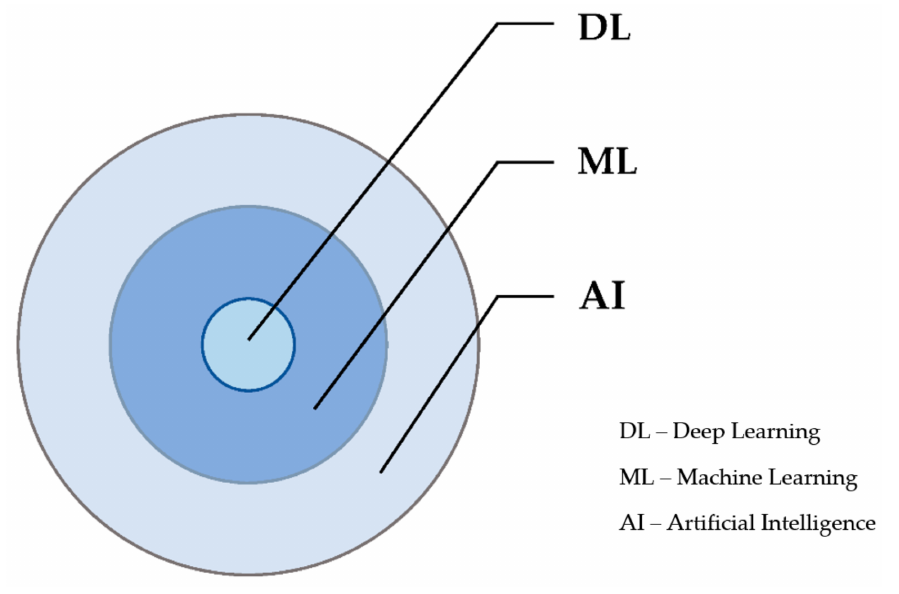
Figure 1. Subfields of artificial